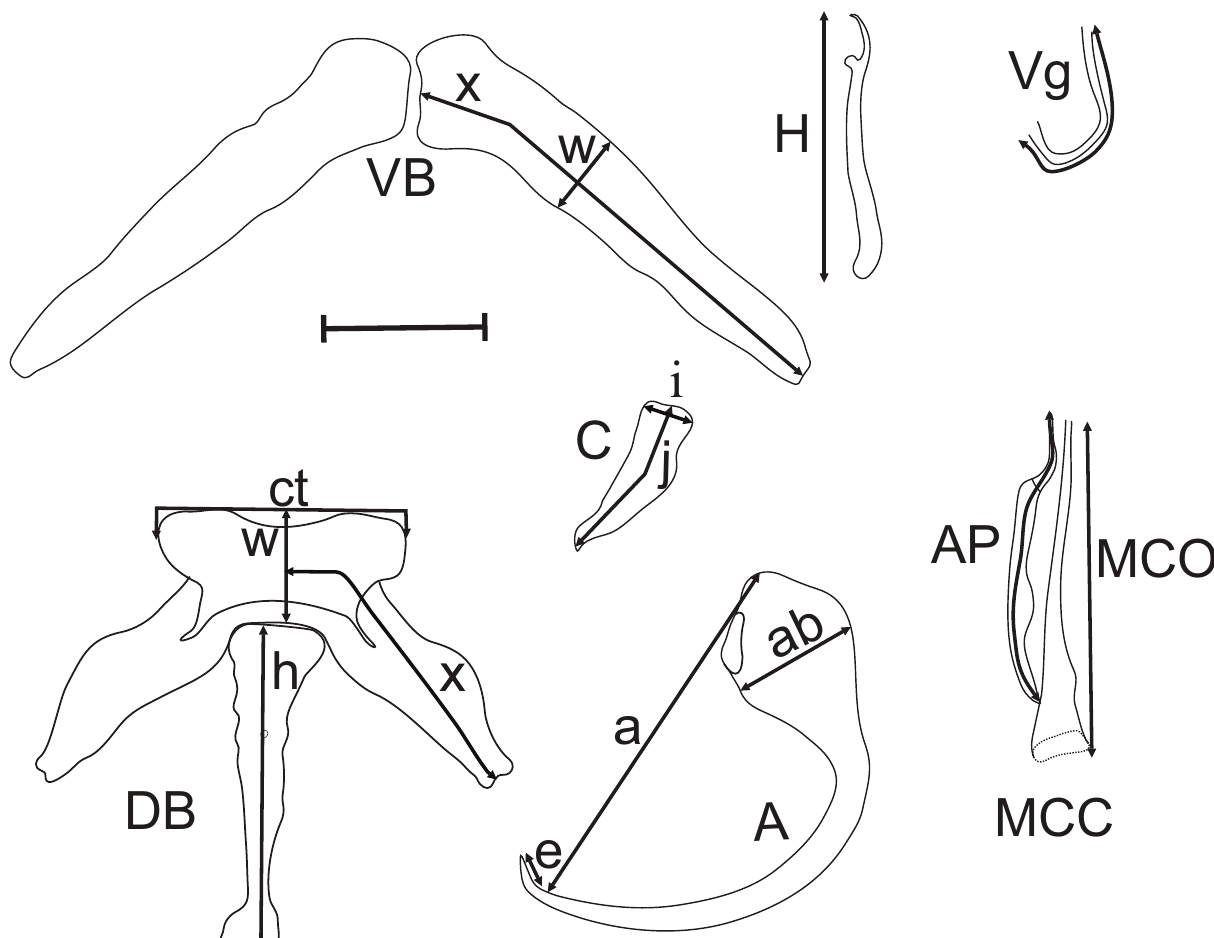
Figure 2. Morphometrics of Quadriacanthus spp. proposed by Gussev (1962) and modi fi ed by N ’ Douba et al . (1999). (A) Anchor: ( a ) length, ( ab ) base width, ( e ) point length; (Ap) Accessory piece length; (MCO) Male copulatory organ length; (C) Cuneus: ( j ) length, ( i ) width; (DB) Dorsal bar: ( ct ) center length, ( h ) median process length, ( w ) width, ( x ) length; (VB) Ventral bar: ( w ) width, ( x ) length; (H) Hook length; (Vg) Vaginal length; scale 20 l